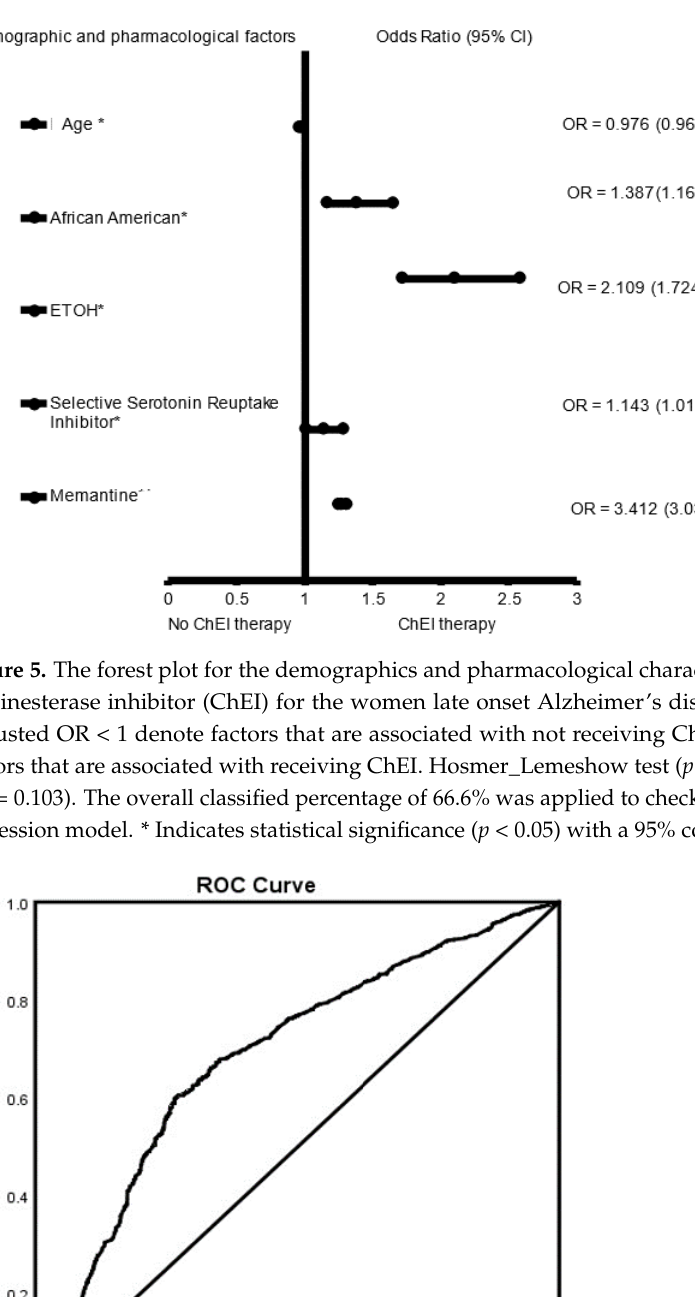
Figure 4. ROC curve associated with prediction of receiving cholinesterase inhibitor (ChEI) for men late onset Alzheimer’s patients. Higher area under the curve (AUC) values in ROC anal ysis indicate better discrimination of the score for the measured outcome. Classification table (overall correctly classified percentage = 70.1%) and area under the ROC curve (AUC = 0.730, 0.711 – 0.749) were ap- plied to check model fitness.